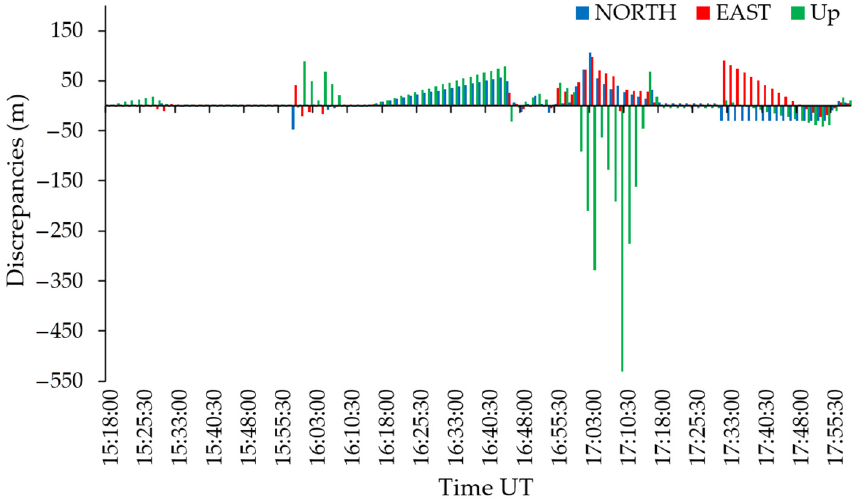
Figure 8. Plot of discrepancies of station RIGA on 17 MAR 2015.